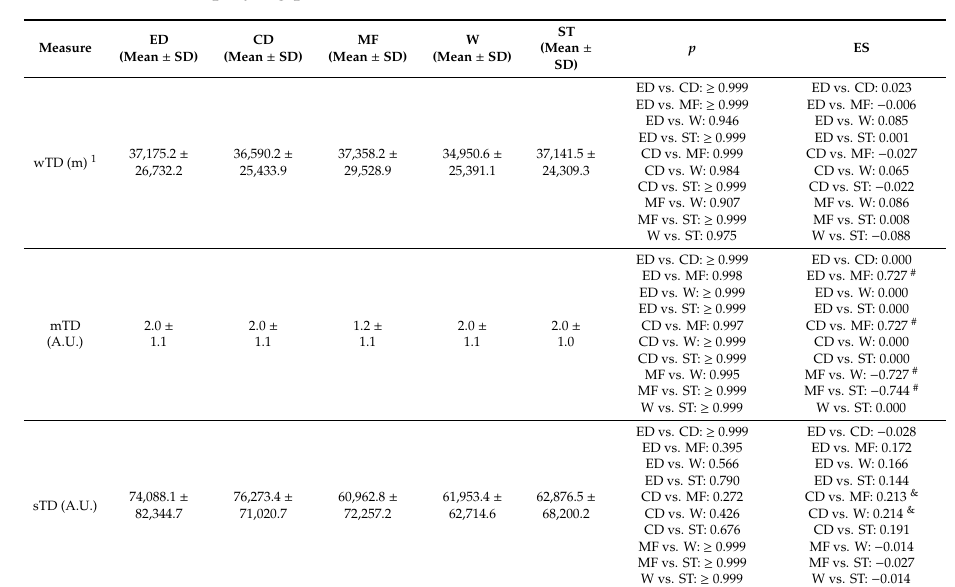
Table 2. Descriptive statistics (mean ± SD) of acute load, training monotony, and training strain for the total distance between playing